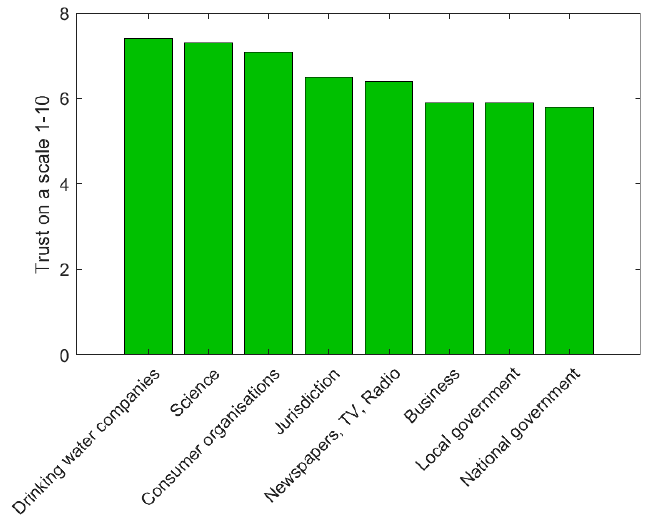
Figure 6. Institutional trust.